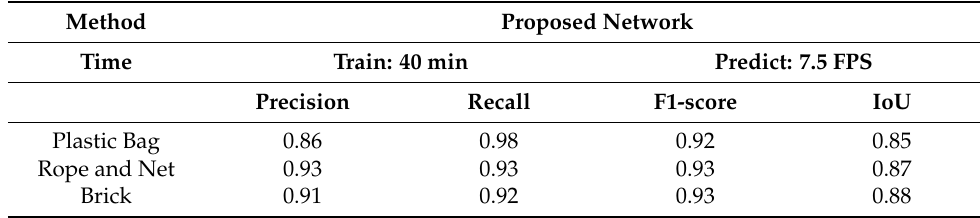
Table 2. Results of the proposed network.